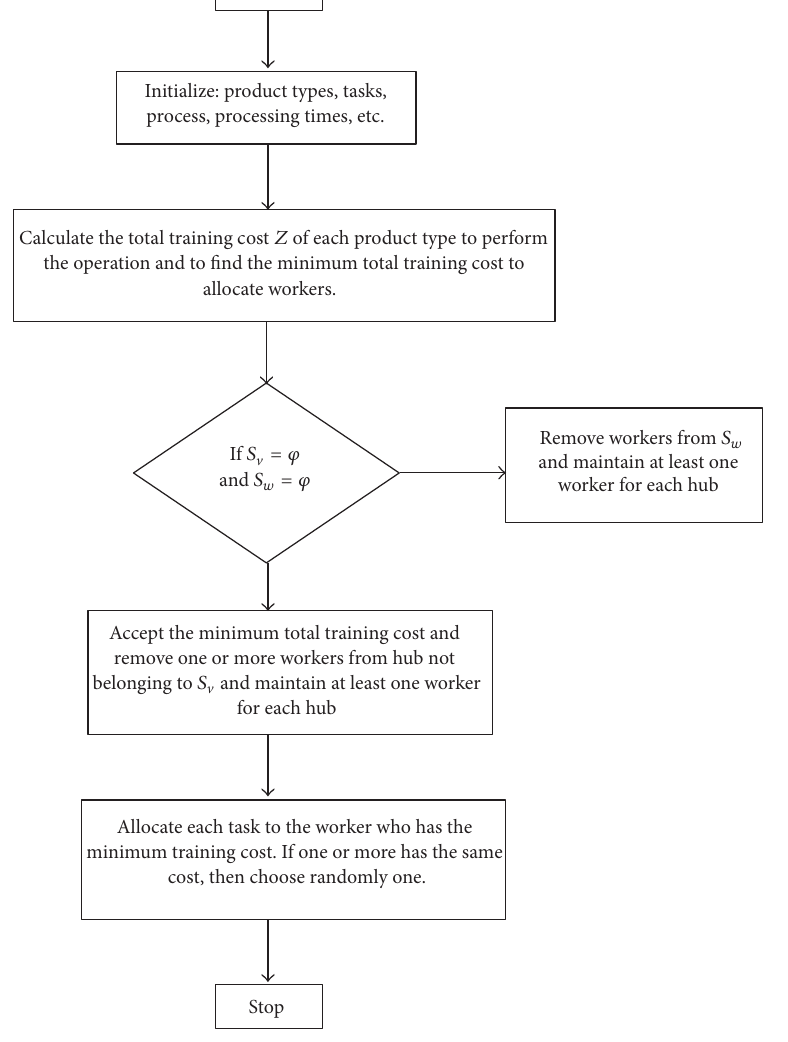
Figure 7: Flowchart of a heuristic approach for assigning jobs to workers.